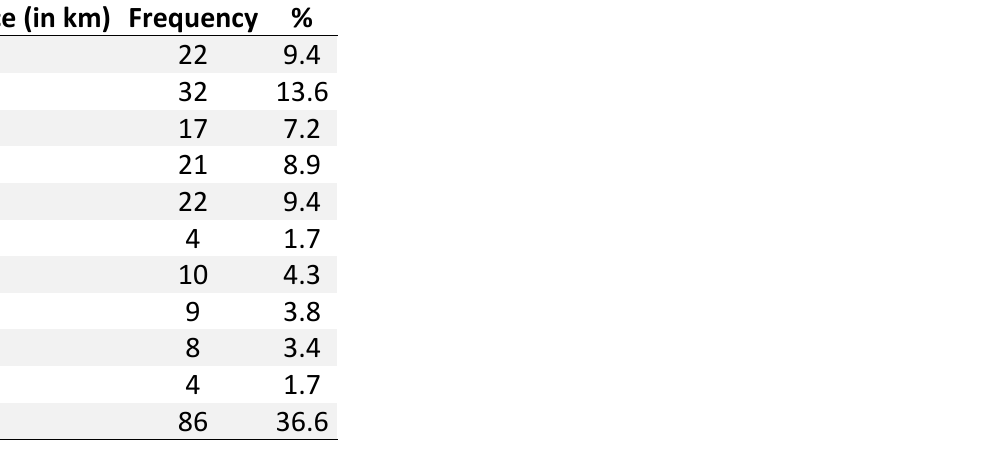
Table 2. Frequency and proportion of ethnographic hunter-gatherer groups, by annual mobility range. (Data taken from Binford 2001: Table 5.01).